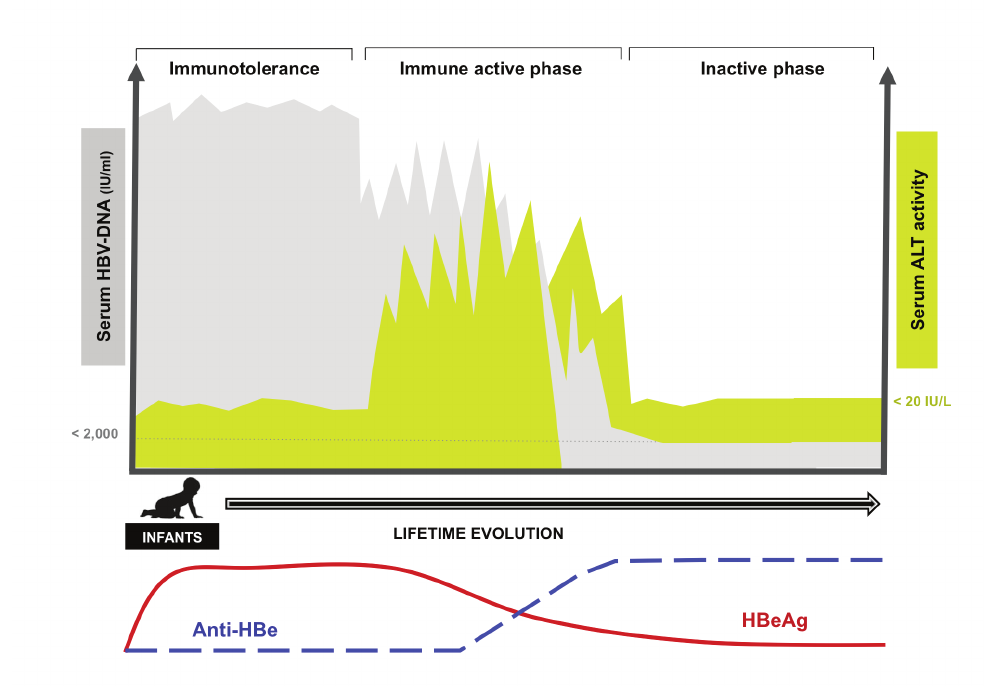
Figure 3: Natural evolution of chronic HBV infection in infants. The long-term course of chronic hepatitis B infection after infant exposure can be typically described in 3 different phases, characterized by different patterns of ALT elevation (green), HBV-DNA levels (grey), and the presence of HBe-Ag (red- line) or anti-HBe